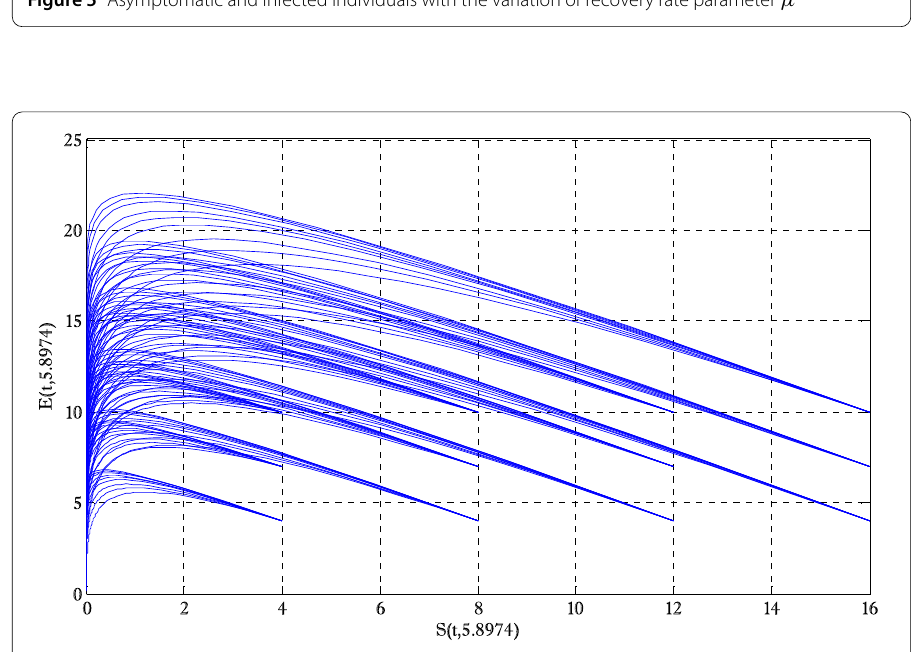
Figure 6 Two dimensional phase portrait of susceptible and exposed individuals